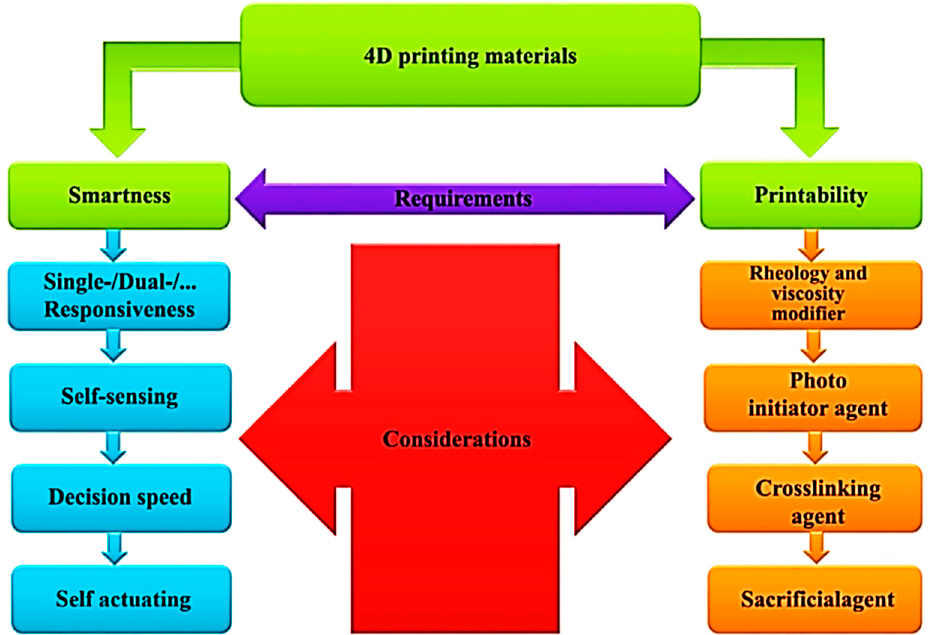
Figure 5. 4D printing methodologies [7]. Reproduced with permission from Elsevier.